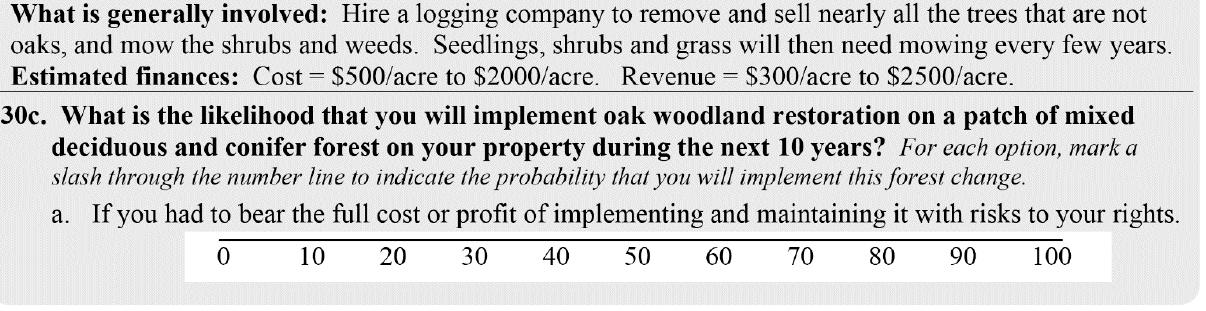
Figure 4. Example survey section for rating a fuels reduction project